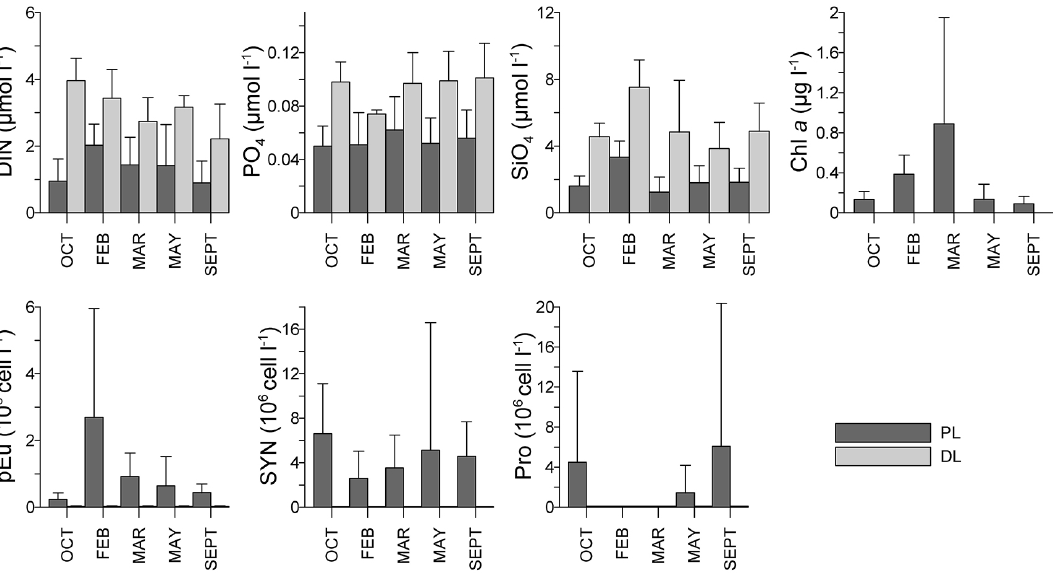
Figure 6. Dissolved inorganic nitrogen (DIN), phosphate (PO 4 ), silicate (SiO 4 ), chlorophyll a (Chl a ), abundances of picoeukaryotes (pEu), Synechococcus (SYN) and Prochlorococcus (Pro) in productive (PL) and deeper layers (DL) during the cruises (3 October 2011, 18